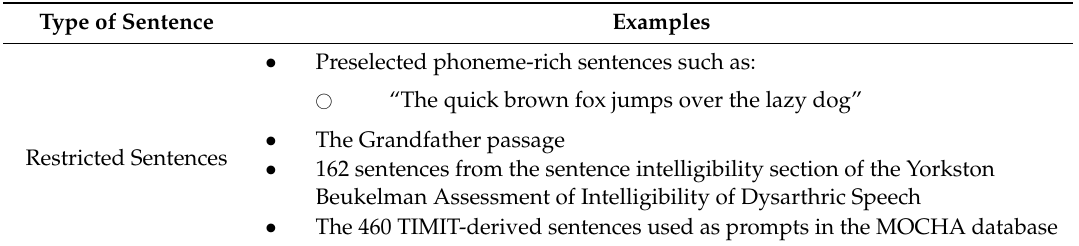
Table A1. Speech stimuli examples from the TORGO database.